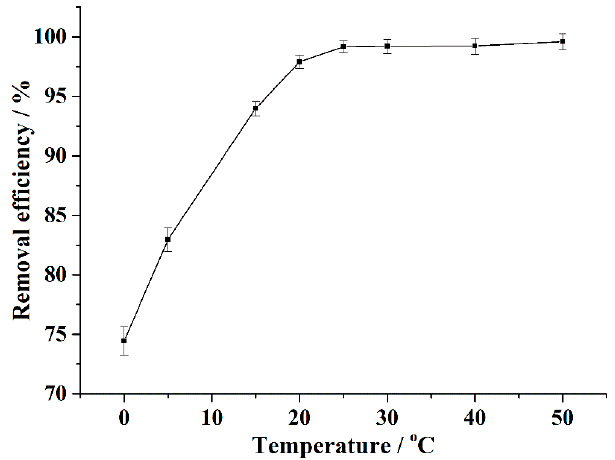
Figure 6. Removal e ffi ciency of Alg–PAM for Pb 2 + at di ff erent ambient Figure 6. Removal efficiency of Alg–PAM for Pb 2+ at different ambient temperatures.